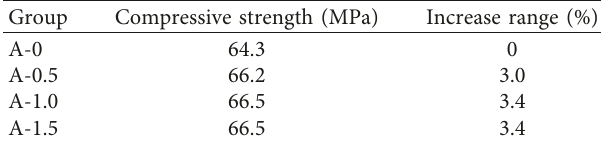
Table 3: Compressive strength test results.